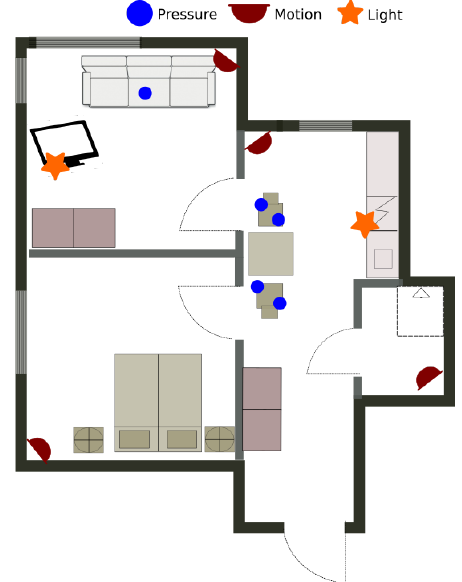
Figure 6. The smart apartment and the position of the sensors for the real apartment data